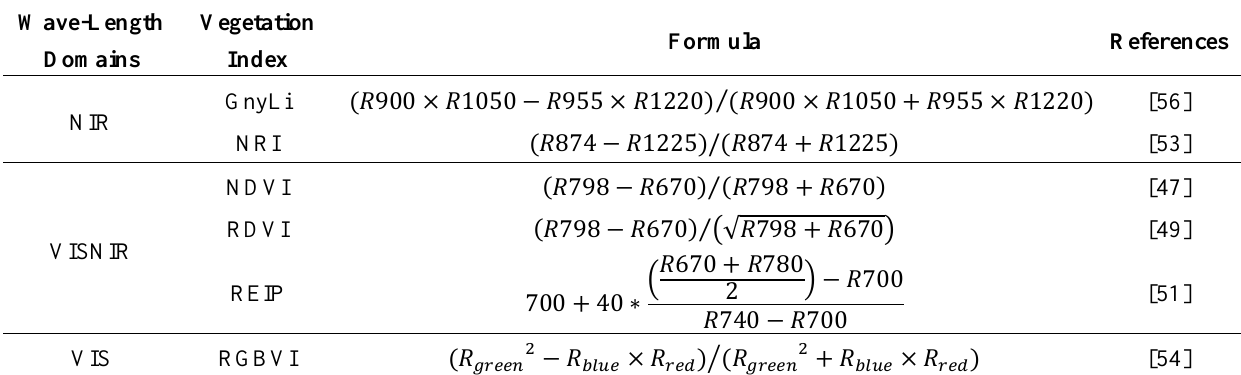
Table 3. Vegetation indices used in this